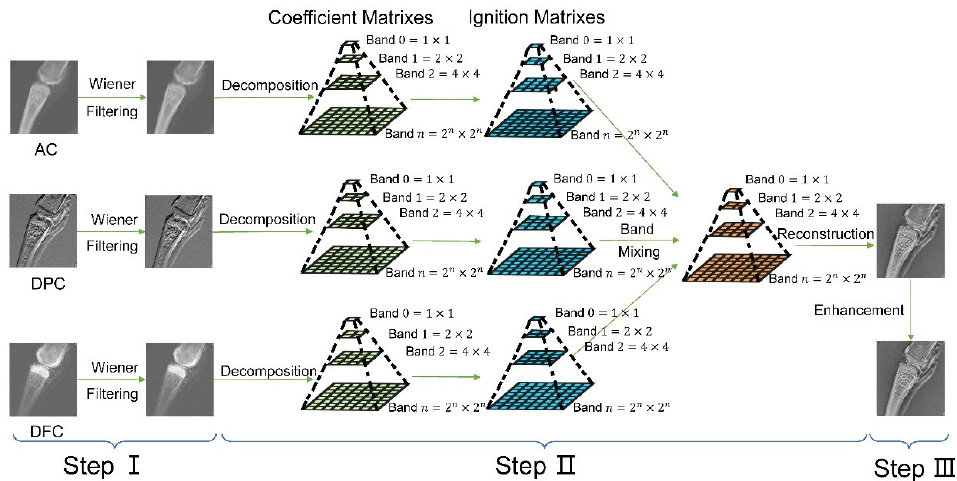
Figure 3. Principle of the NSCT-SCM XGI fusion scheme. Step I: Images are denoised using Wiener filtering. Step II: Images are decomposed into coefficient matrixes using NSCT. Then, the coefficient matrixes are proposed by SCM, outputting ignition matrixes. Finally, band mixing is implemented (three coefficient matrixes are fused into one coefficient matrix based on a coefficient selection algo- rithm designed on the basis of ignition matrixes), and the fused image is obtained by reconstructing the fused coefficient matrix. Step III: The fused image is enhanced to generate the final output